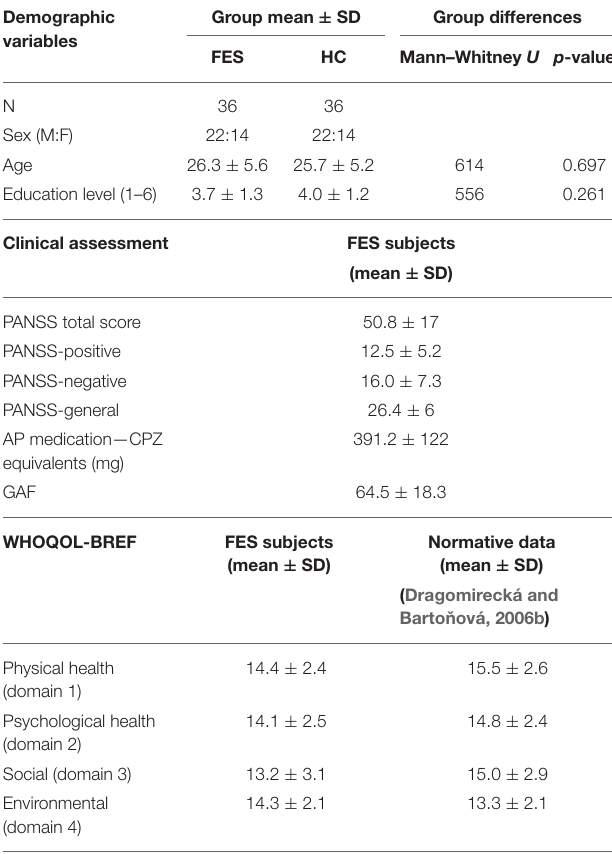
TABLE 1 | Demographic data, clinical assessment, and QOL